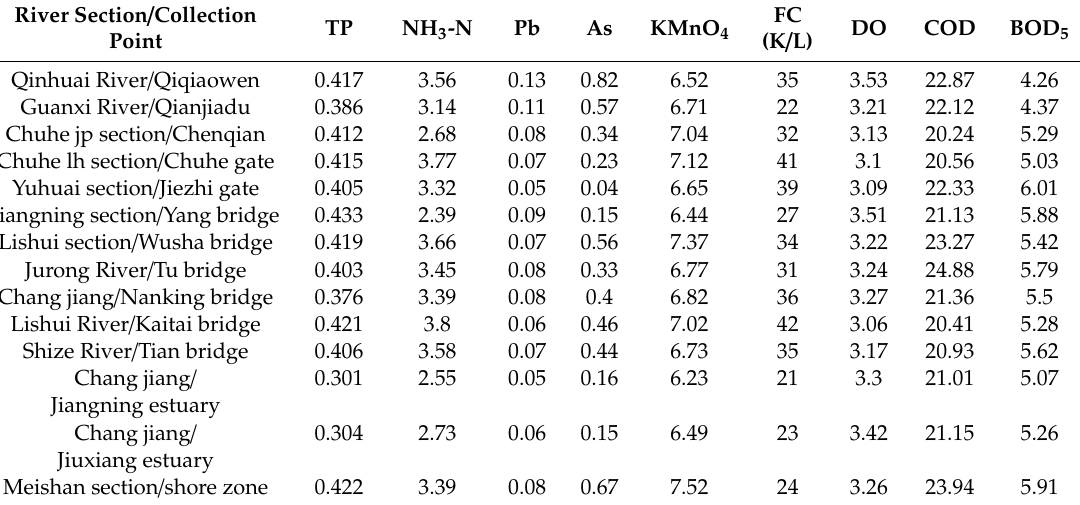
Table 3. Surface water quality standard.